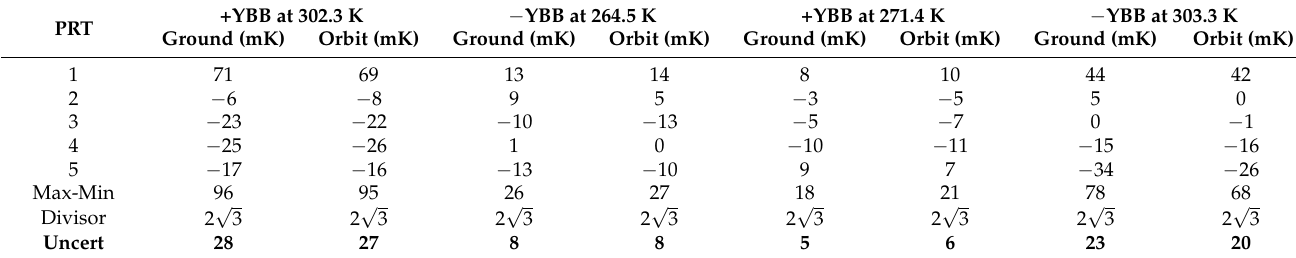
Table 6. Temperature differences of the SLSTR-B blackbody baseplate PRTs relative to the average cavity baseplate temperature from on-ground and in-orbit for different combinations of blackbody temperatures. The thermal environment of the BBC is ~260K [18]. For SLSTR, one blackbody mounted on the +Y side of the satellite (+YBB) is normally heated and the one mounted on the opposite -Y side (-YBB) is normally unheated and floating close to ambient. The divisor 2 chosen as the standard deviation of a rectangular probability distribution, the distribution is bound by the upper and lower temperature readings of the